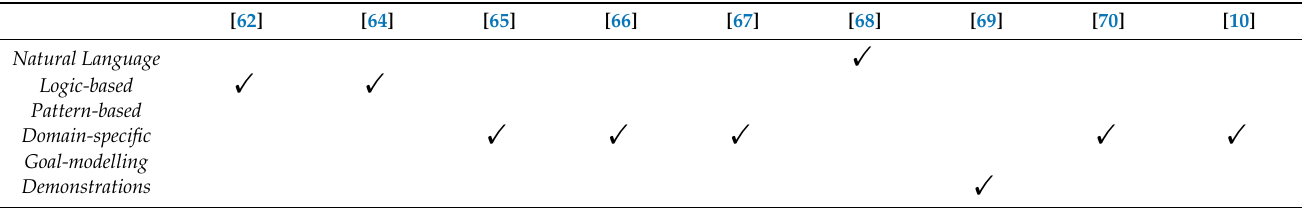
Table 1. Requirements specification technique used by the papers published in AREA 2020 ([63] is not reported in the table since it does not consider MAS